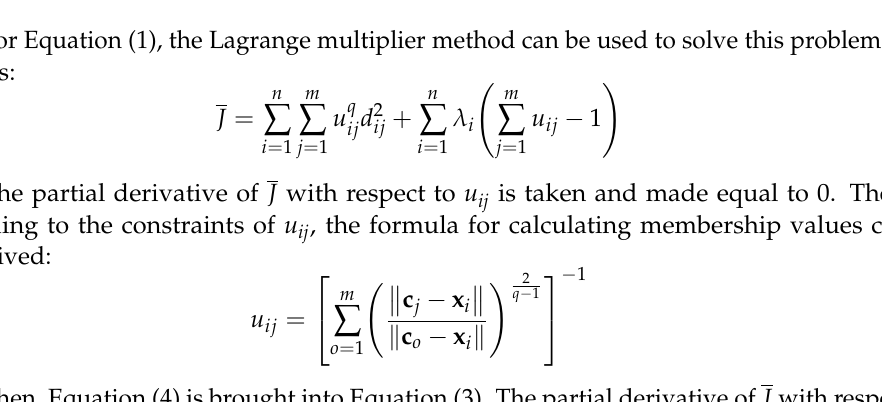
Figure 1. Flowchart of the proposed SSGIE ‐ KFCM method.